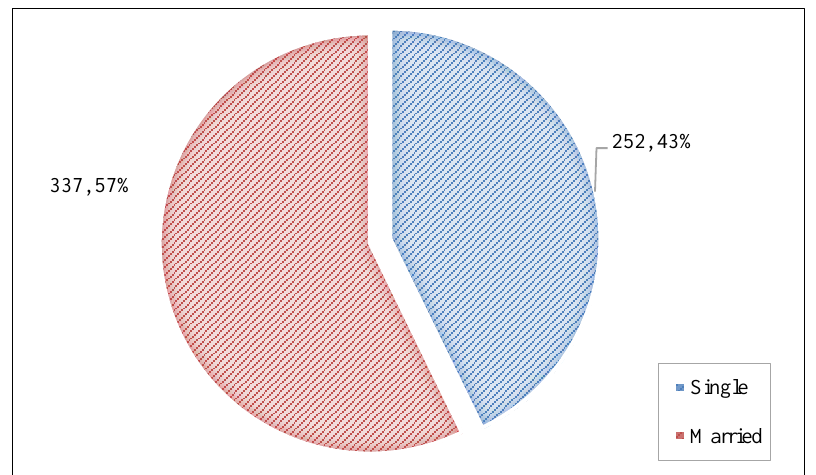
Figure 4. Statistical results for marital status